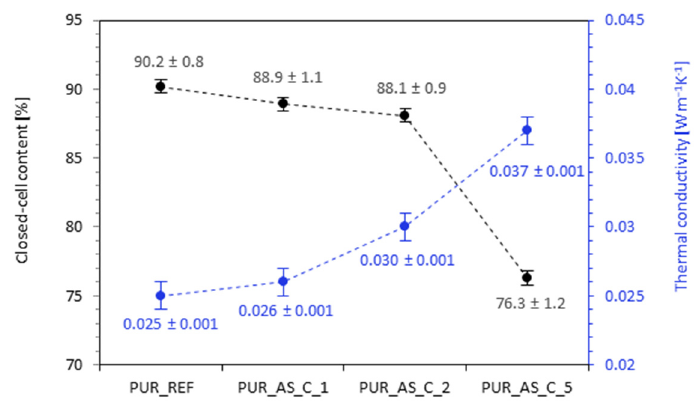
Figure 10. The results of closed-cells content and thermal-conductivity analysis.